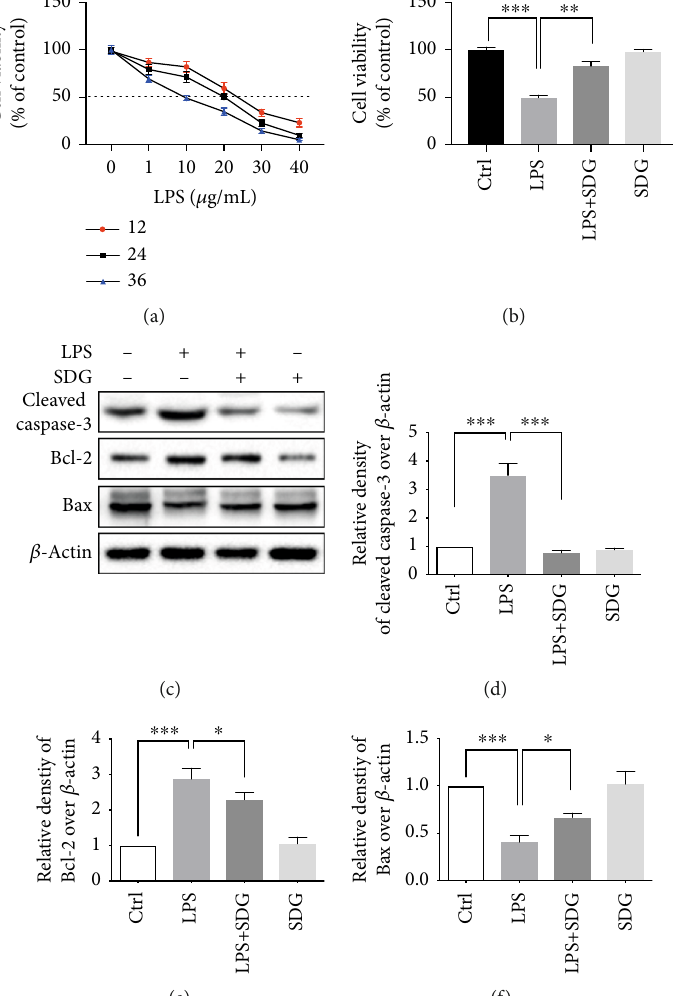
Figure 2: SDG mediated reduced LPS-mediated cell injury and apoptosis. (a) LPS (0, 1, 10, 20, 30, and 40 μ g/mL) was used to treat HUVECs for 12, 24, and 36h. Cell viability was analyzed by CCK-8 assay. (b) Pretreated the cells with SDG (10 μ M) for 24 h, followed by LPS for 24h. SDG increased the survival rate of cells in LPS-induced HUVECs. (c) Representative immunoblots of cleaved caspase-3, Bcl-2, and Bax proteins in di ff erent groups. (d – f) Semiquantitative analysis of the relative levels of cleaved caspase-3, Bcl-2, and Bax by a densitometric analysis. Error bars represent mean ± s : d . ∗ , ∗∗ , and ∗∗∗ represent p < 0 : 05 , p < 0 : 01 , and p < 0 : 001 , respectively. All experiments were performed in triplicate. LPS: lipopolysaccharide; SDG: secoisolariciresinol diglucoside.